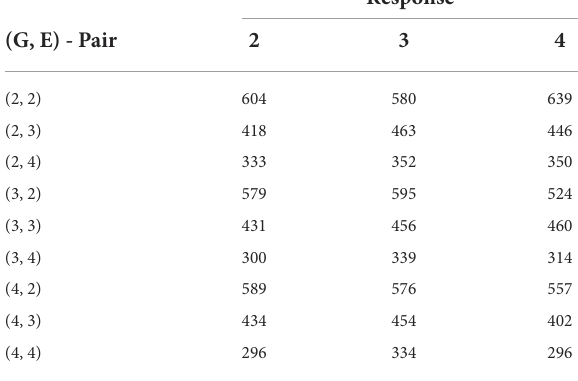
TABLE 5 Biclustering results with the smallest SSE values obtained from fitting no-interaction models on each bicluster for raw responses (30 trials - maize